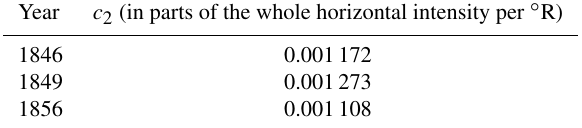
Table 2. The temperature coefficients found in the yearbook (Böhm and Karlinski, 1857, p. XV) and corrected by us